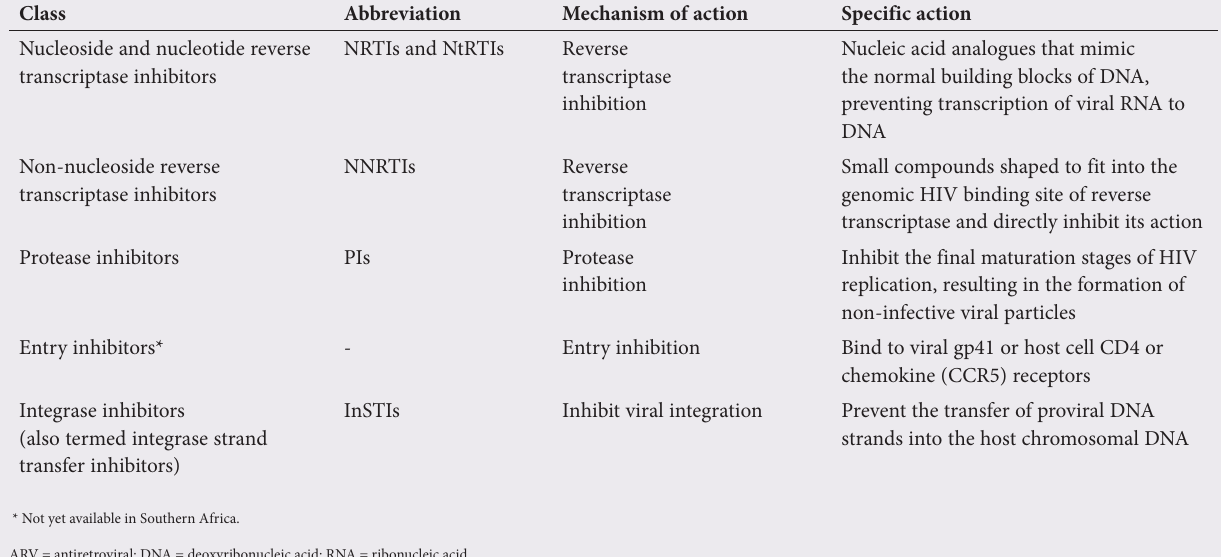
Table 1. Classes of ARV